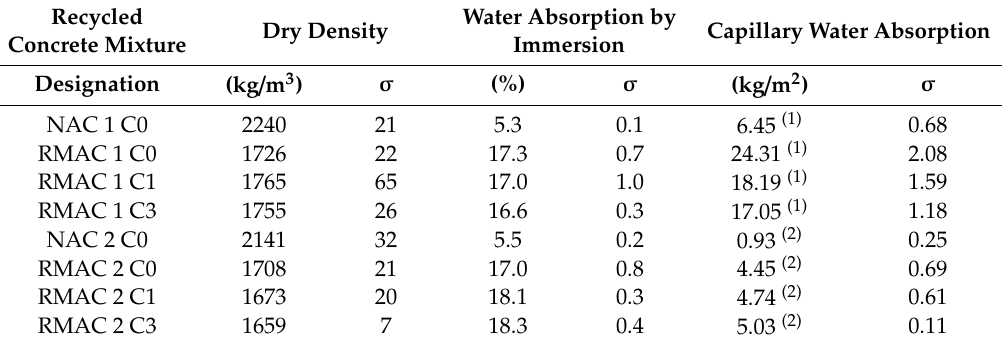
Table 3. Average values of results of physical properties of concrete, including standard deviation.